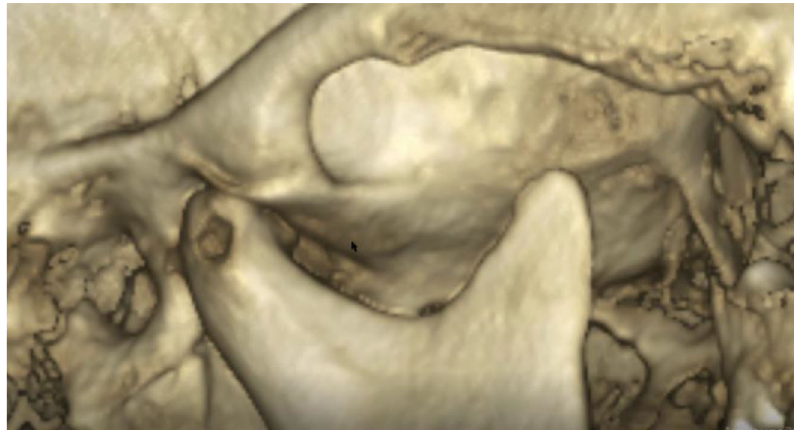
Figure 5. Right TMJ condition with